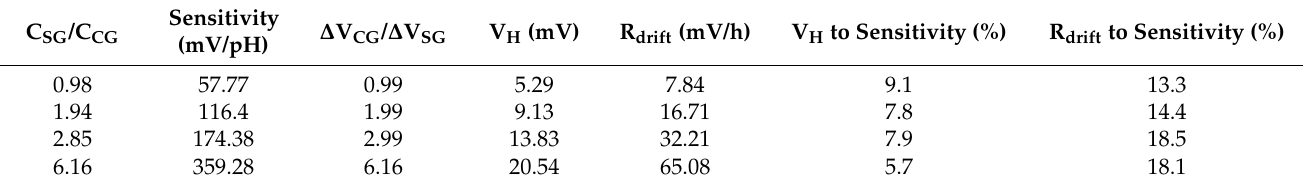
Table 2. pH sensing characteristics of the a-IGZO coplanar dual-gate TFT pH